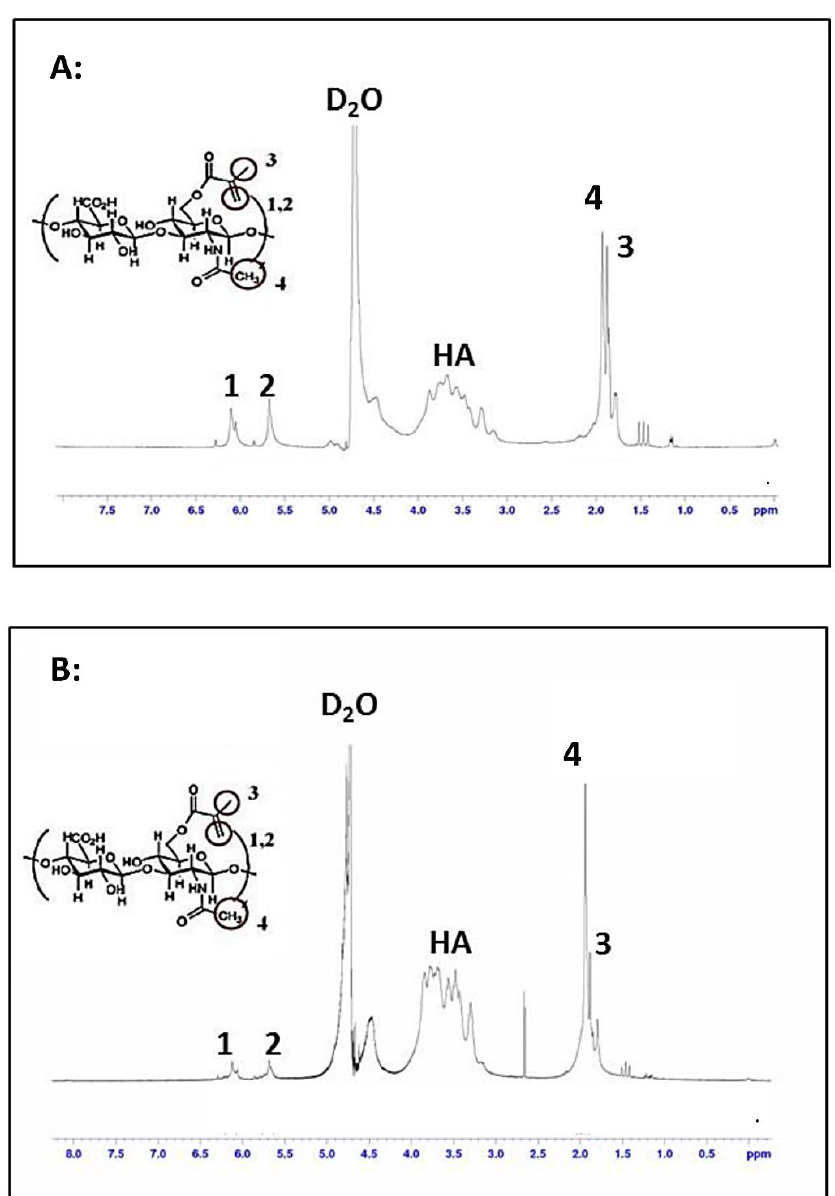
Figure 2. 1 H- Nuclear Magnetic Resonance (NMR) characterization of hyaluronic acid (HA) and MeHA. D 2 O was used as solvent. Peak labelled HA represents hyaluronic acid. Presence of peaks 1, 2, and 3 illustrates the successful methacrylation of HA. Peak 4 represents a methyl group on HA. ( A ) NMR characterization of MeHA synthesized using 20-fold excess of methacrylic anhydride and reaction time of 24 h. Degree of methacrylation (DM) = 77.4%. ( B ) NMR characterization of MeHA synthesized using 6-fold excess of methacrylic anhydride and reaction time of 10 h. DM = 37.8%.